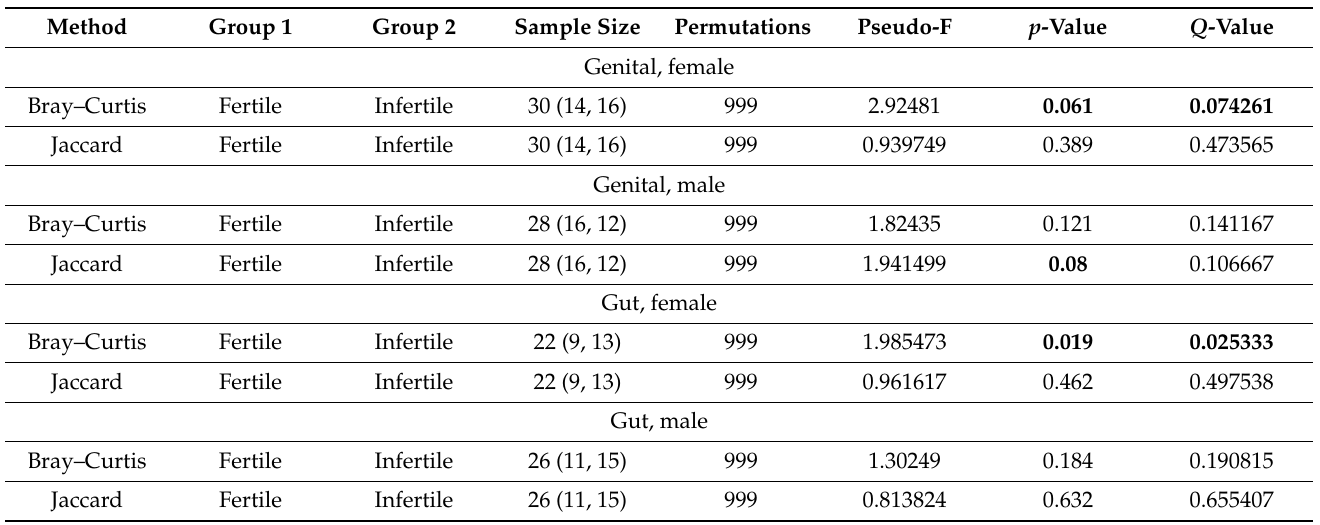
Table 8. Differences in the beta-diversity of EC metagenome between samples. (PERMANOVA, <0.1 are in